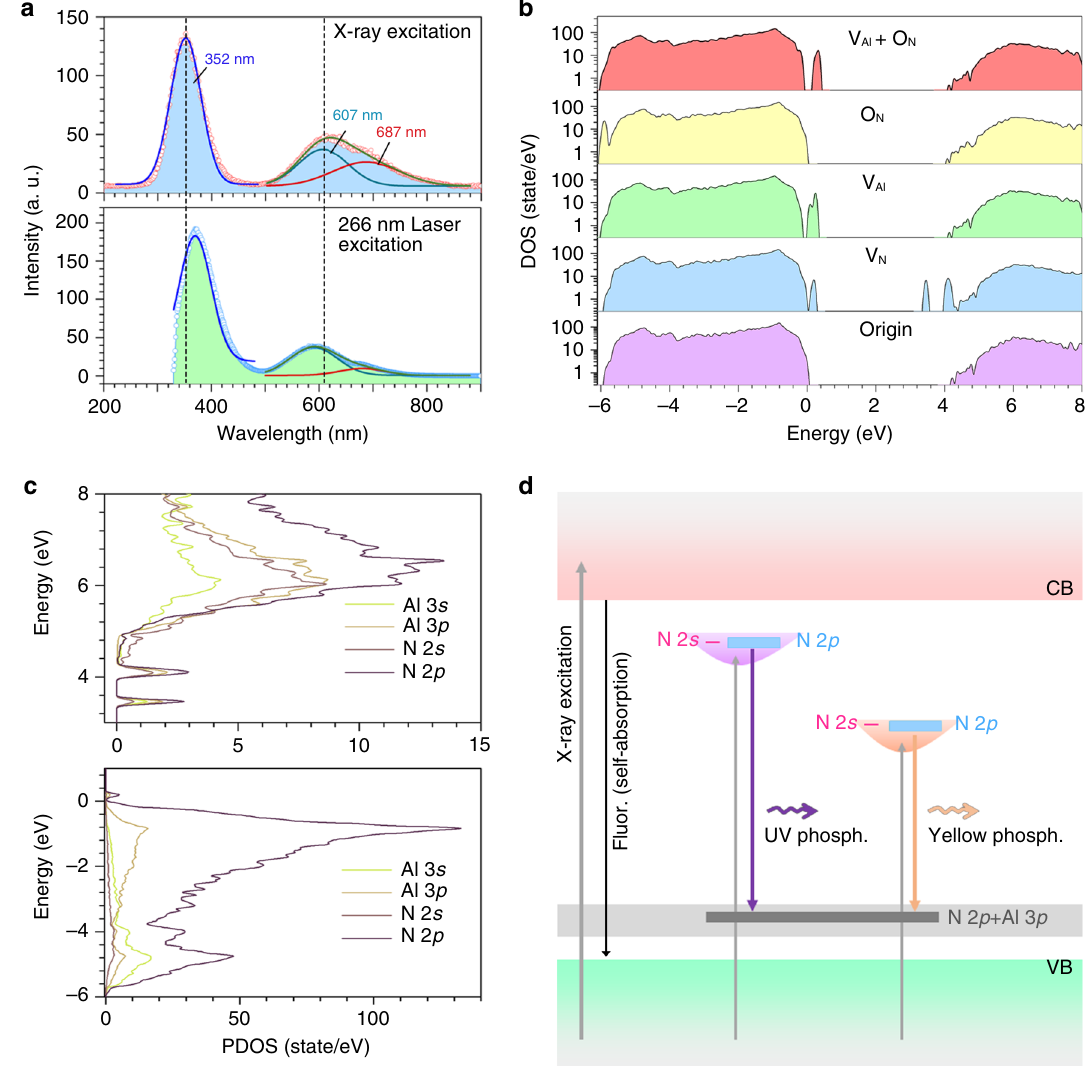
Fig. 3 Mechanism of ultralong intrinsic phosphorescence. a PL spectra of AlN SC under X-ray and 266nm laser excitation, respectively. b The DOS of AlN with potential defects, including V N , V Al , O N , and couple of V Al and O N . c The PDOS of AlN with V N defect that introduces two donor energy levels and an acceptor energy level in inner bandgap. d Energy band diagram describes the radiative transition mechanism of phosphorescence (Phosph.) with stable transition from N 2 p orbit to N 2 p + Al 3 p